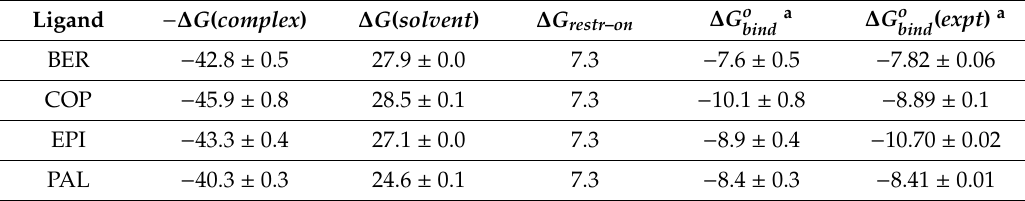
Table 3. The DDM-calculated absolute binding free energies ∆ G o Unit: kcal /